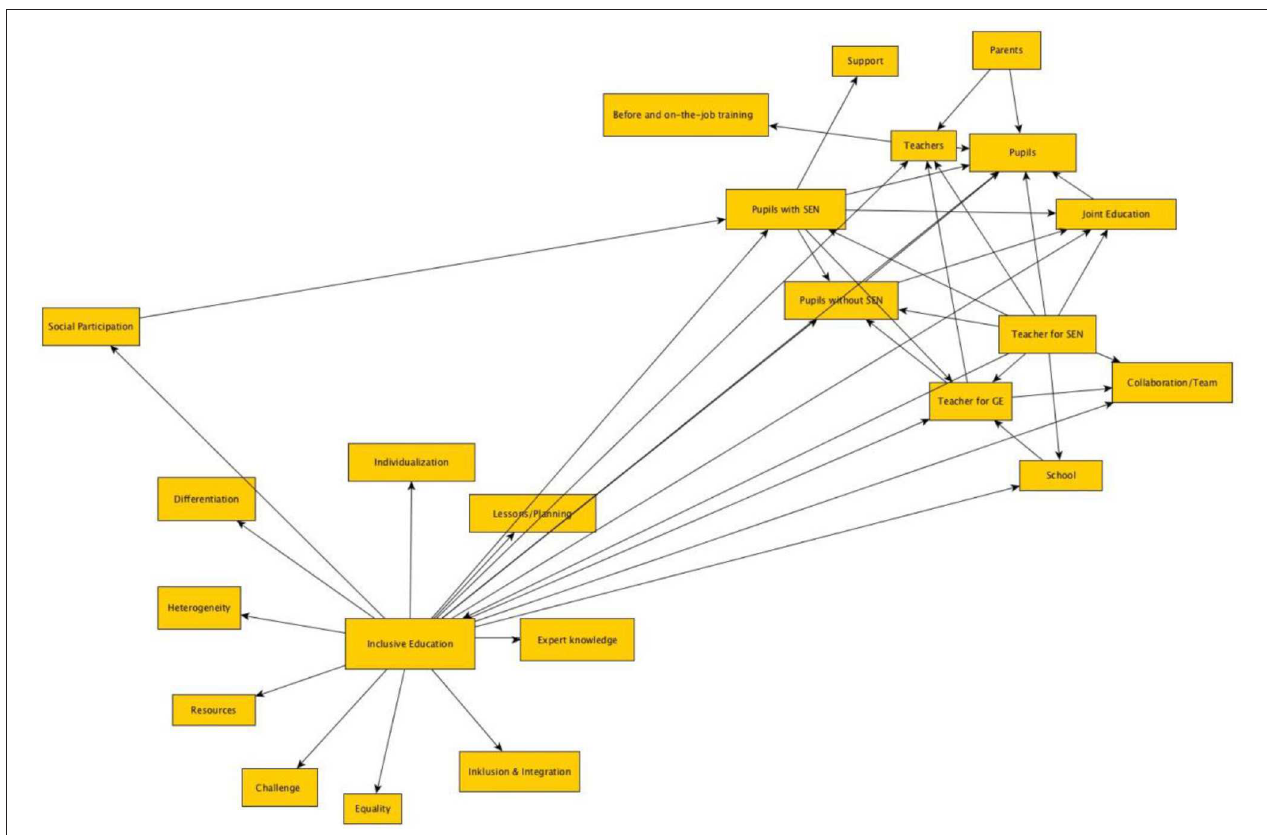
FIGURE 1 | Pathfinder network of all teacher trainees at t1 ( N =